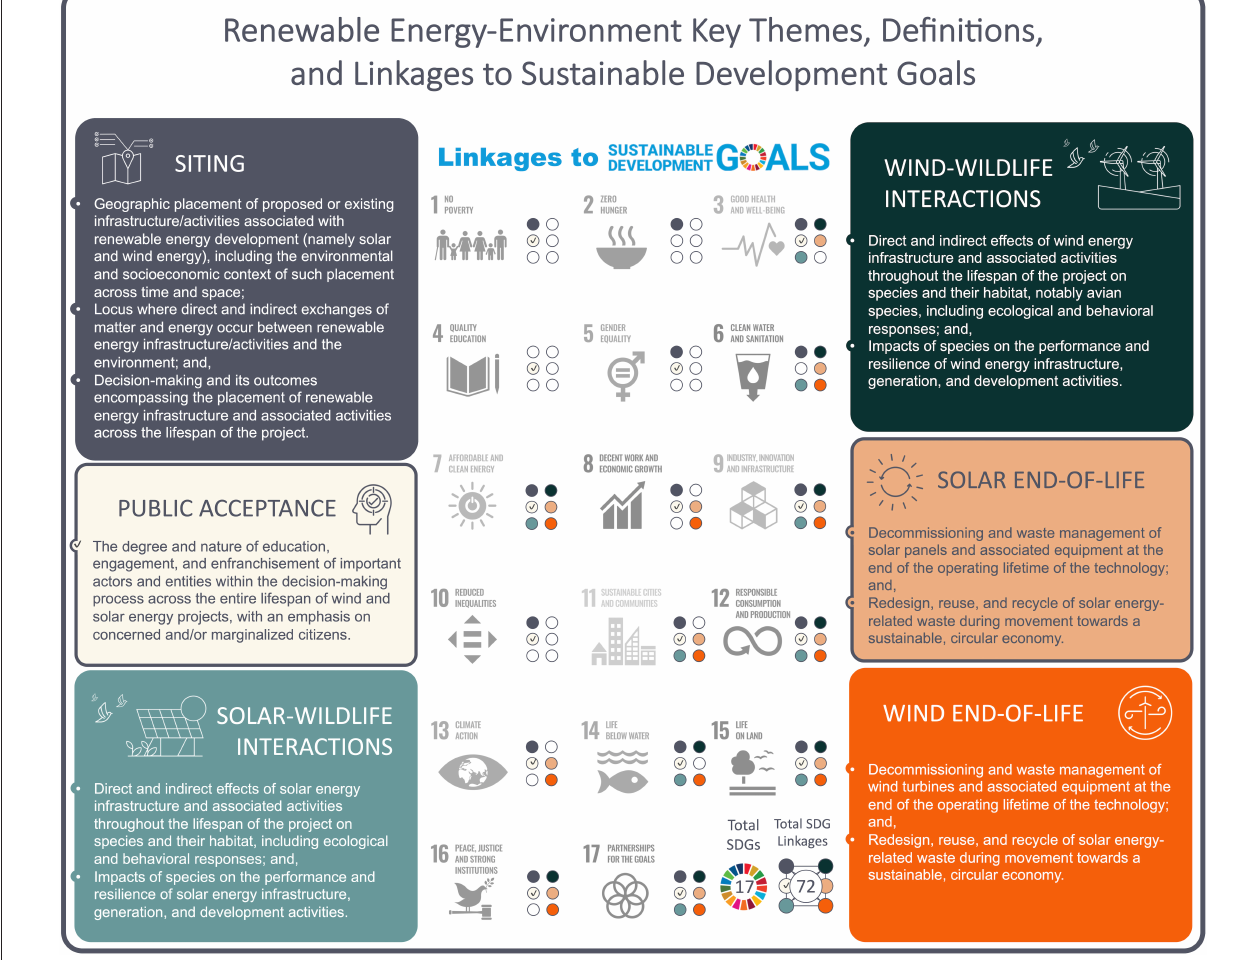
FIGURE 3 | Formal definitions of environmental research themes for wind and solar power and their linkages to United Nations Sustainable Development Goals (SDGs). Filled circles represent one of six themes that have potential to reinforce and/or inhibit progress toward SDGs. A total of 17 SDGs are represented across all six themes owing to 72 total unique linkages confirmed with supporting literature (see Supplementary Material for methods and references). Graphics use icons reproduced from the Noun Project